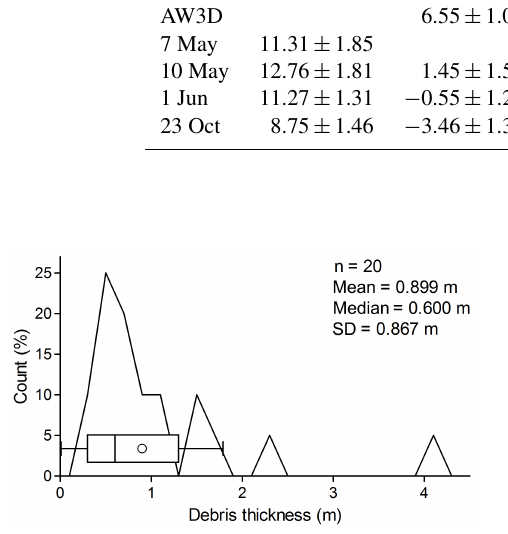
Figure 6. Histogram and box plot of debris thickness found at ice cliffs. Box, line, and circle in the box-and-whisker plot denote in- terquartile, median and mean, and 1 standard deviation, respec-